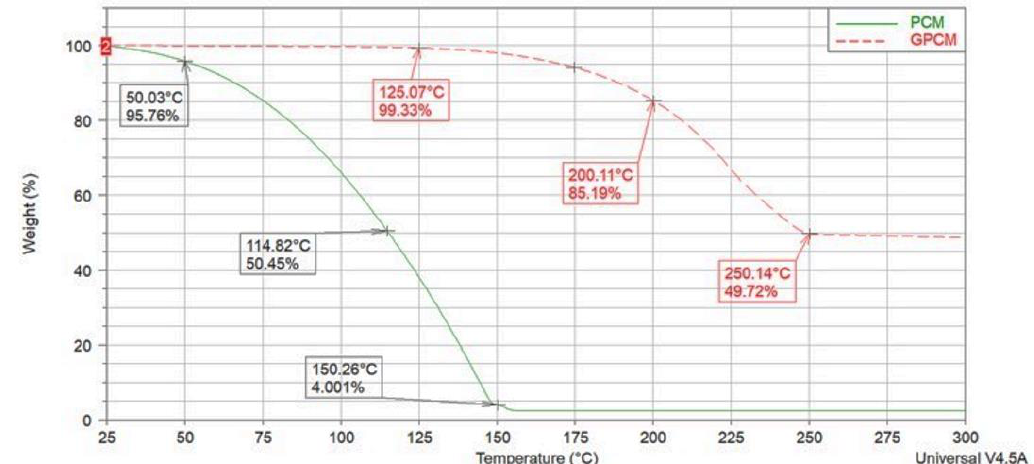
Figure 8 . TGA spectrum of PCM and GPCM . Figure 8. TGA spectrum of PCM and GPCM. Table 4. Initial, medium, and maximum evaporation temperatures obtained from